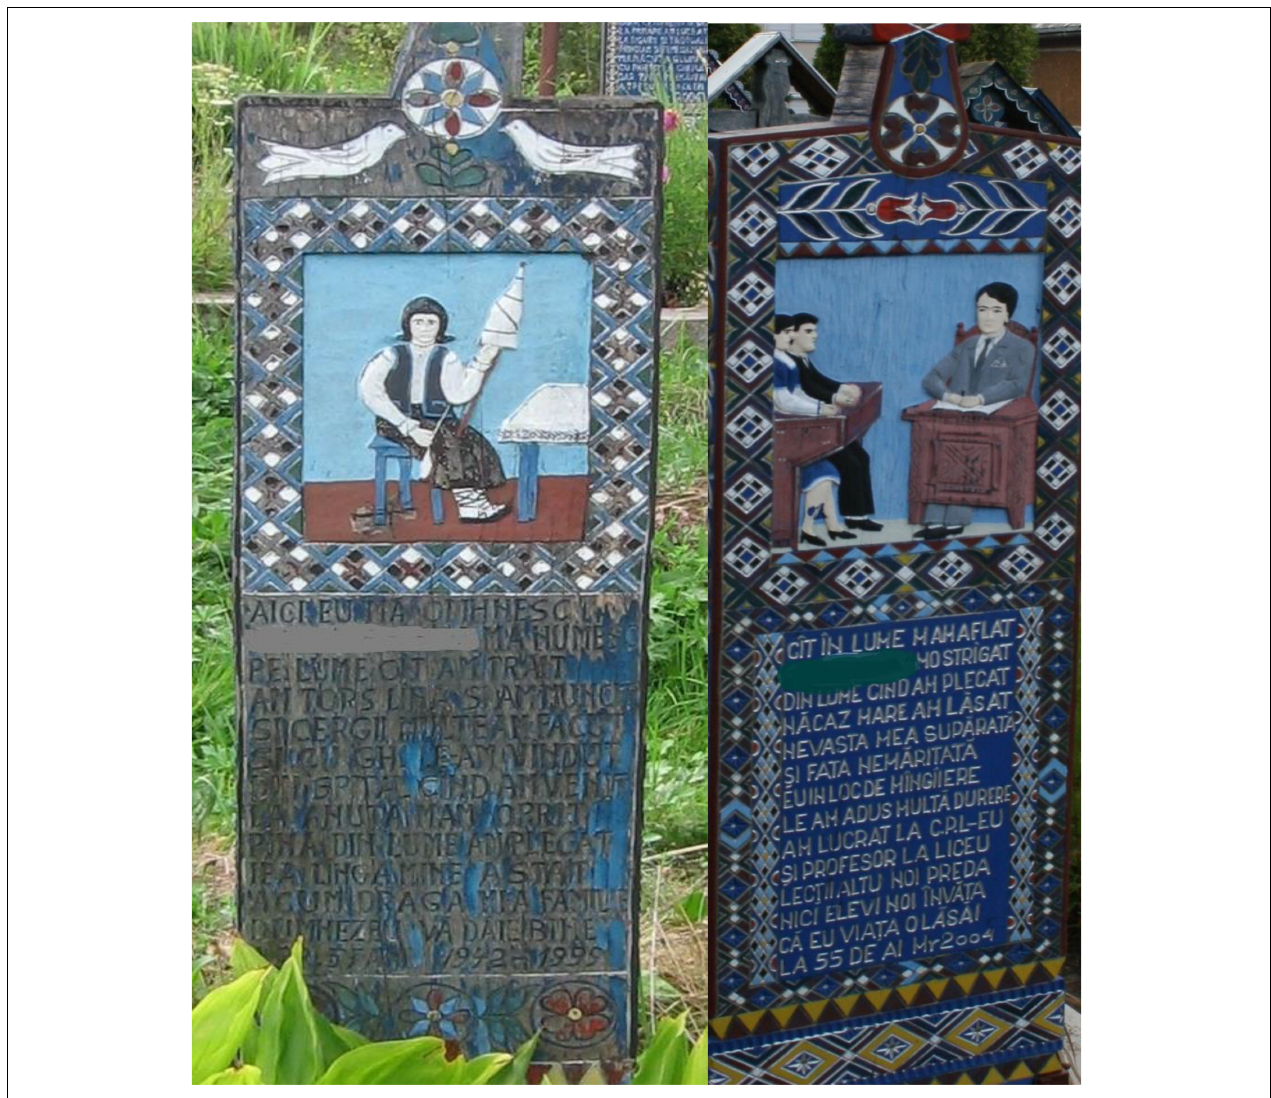
FIGURE 1 | Examples of occupations depicted on the painted crosses of the Merry Cemetery of S˘apân¸ta. Translation of the epitaph on the left: Here I lie to take my rest/And SI is my name/As long as I lived/I worked by hand spinning the wool/And I weaved many rugs/Sold them with GH/When from hospital I returned/Anuta took good care of me/Until I left this world/And now my dear family/I wish God will bless you all ; Translation of the epitaph on the right: As long as I lived/People called me OP/When I departed from this world/Misfortune I left behind/An upset wife/And an unmarried daughter/Instead of comfort/I brought them only pain/I worked at CPL and I was also a high school teacher/ But I will teach no longer/Nor will I guide pupils/As I died at